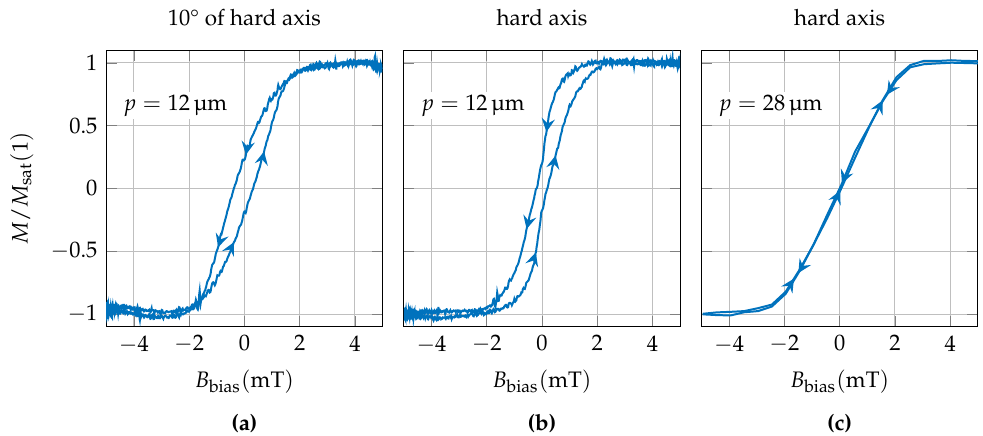
Figure A1. Magnetization curve of the SAW device with p = 12µm measured by a hysteresis loop tracer model 108 (Shb Instruments). The normalized magnetization parallel to the delay line ( a ) and to the hard axis ( b ) are shown. ( c ) Shows the Magnetization curve of a SAW device with p = 28µm [5]. The arrow marks represent the direction of the magnetization process starting from a magnetically saturated